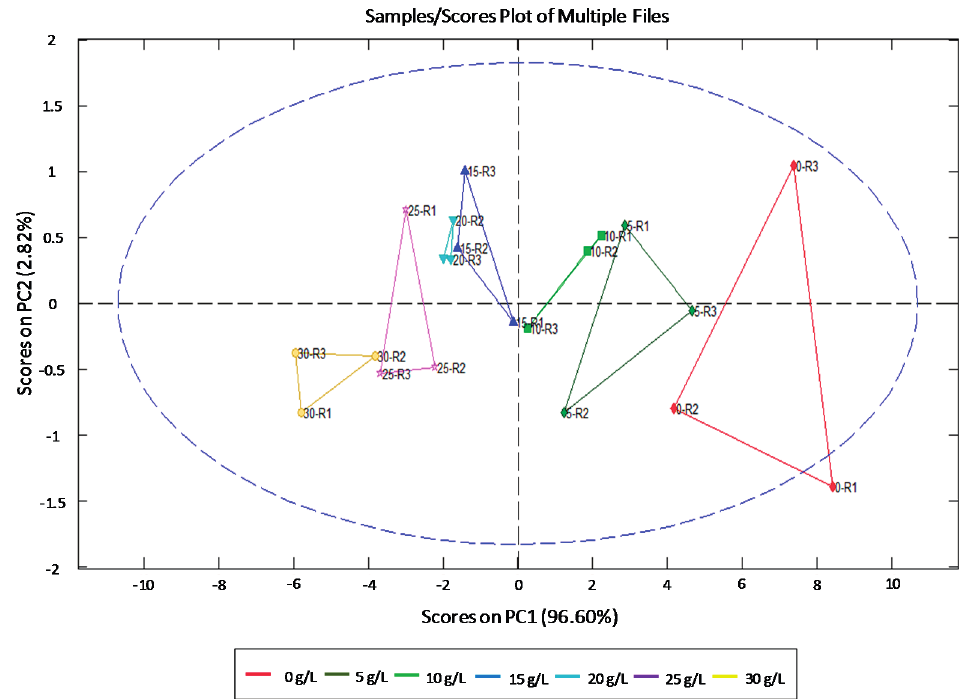
Figure 4. Principal component analysis (PCA) for the studied sucrose concentrations. R1–3: average of each replicate. The blue ellipsis indicates 95% confidence